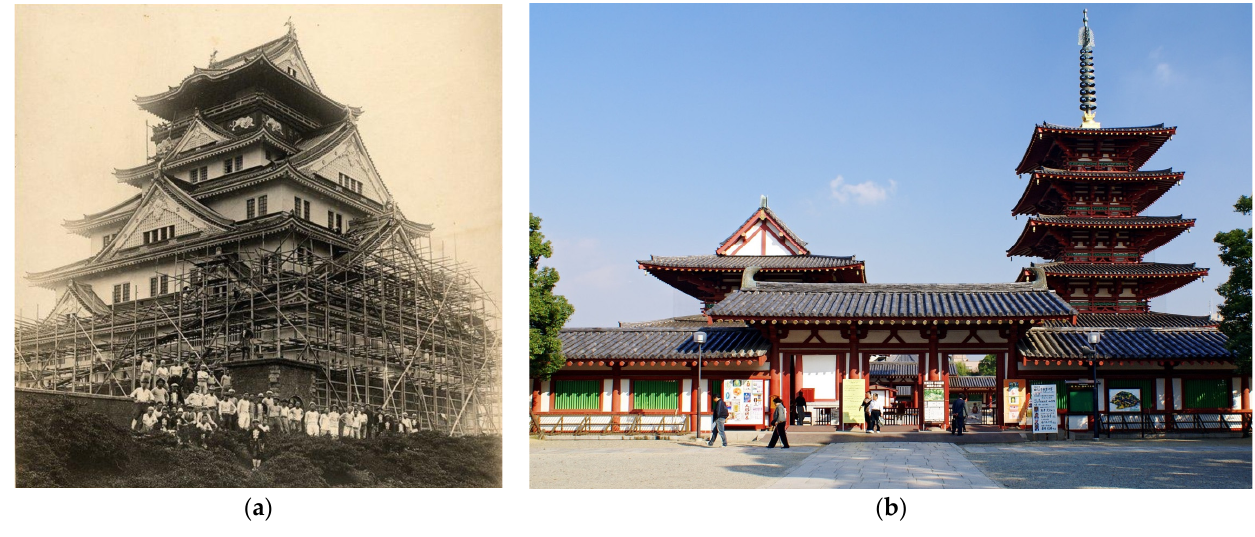
Figure 19. Reconstruction of Japanese Cultural Heritage in Concrete: ( a ) Osaka Castle (completed in 1931 by Obayashi Corporation) ( b ) Shitennoji Temple (completed in 1967).